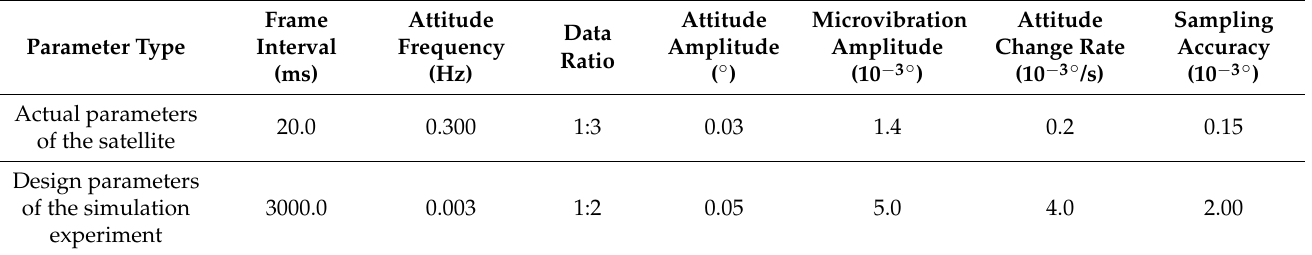
Table 1. Comparison of the actual parameters of the satellite and the design parameters of the simulation experiment.